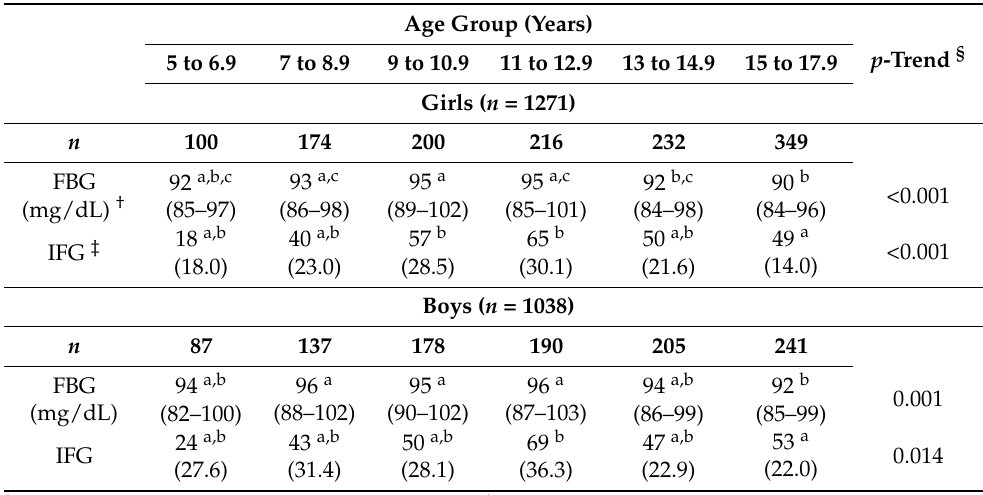
Table 2. Comparison of fasting blood glucose (FBG) and impaired fasting blood glucose concentration (IFG) in the subsample of participants by sex and age group ( n =